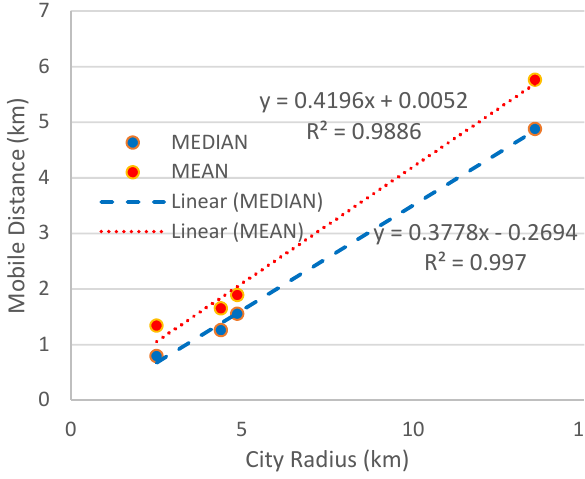
Figure 7. Relationship between city radius and users’ average mobile distance.